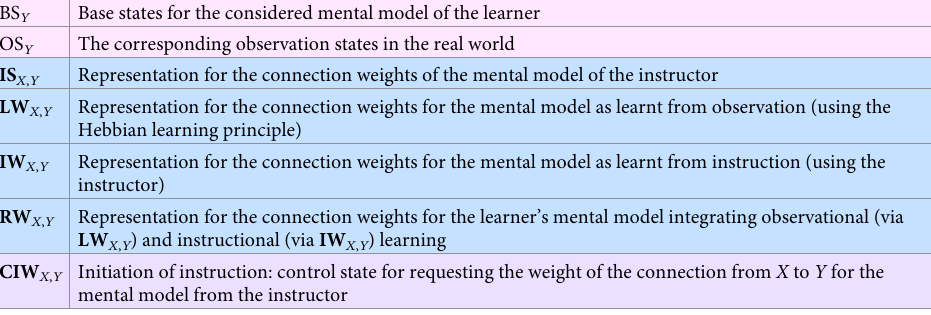
Table 1. Types of states in the introduced three level network